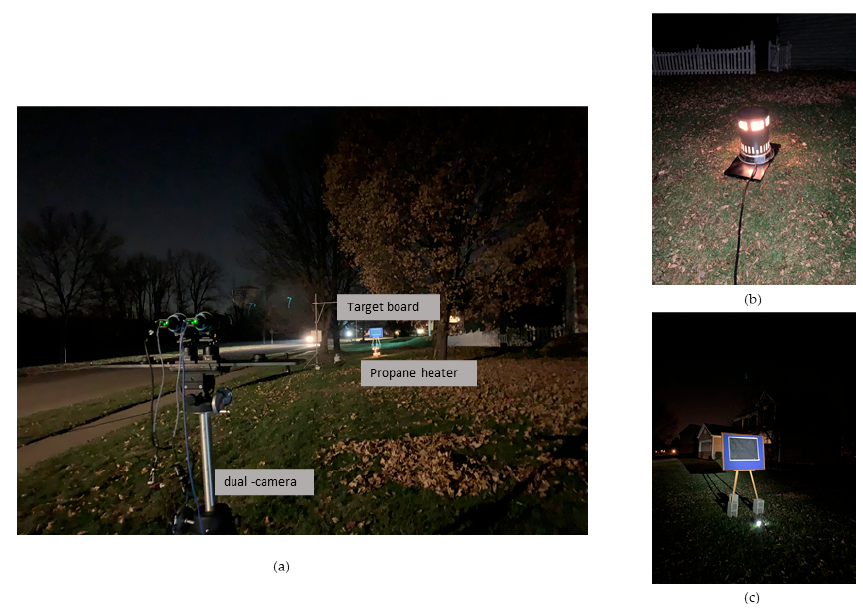
Figure 6. Experimental setup for the short-range experiment. ( a ) Experimental path; ( b ) The gas heater used to create a local spike in turbulence; ( c ) Target board.